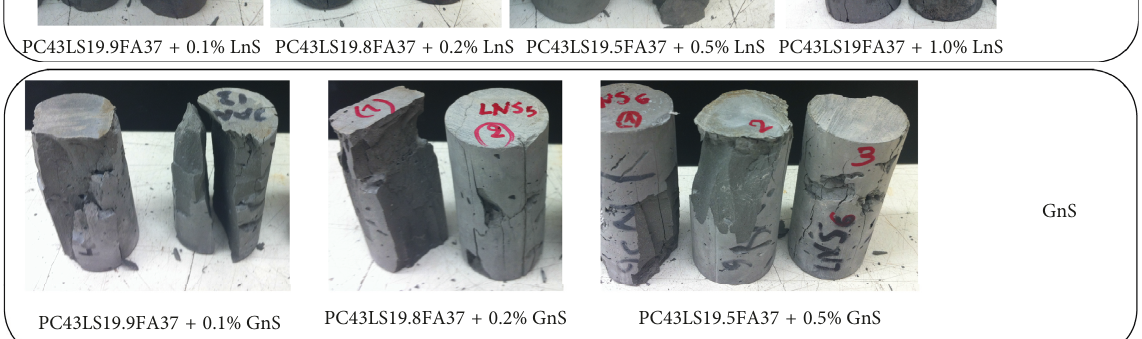
Figure 11 showed a significant increase in the C–S–H and ettringite directly linked with the consumption of Ca(OH) 2 content from day 28 to day 56 and, consequently, the strength gain observed at these ages for specific pastes. Additionally, the following can be observed in the graphs that follow: